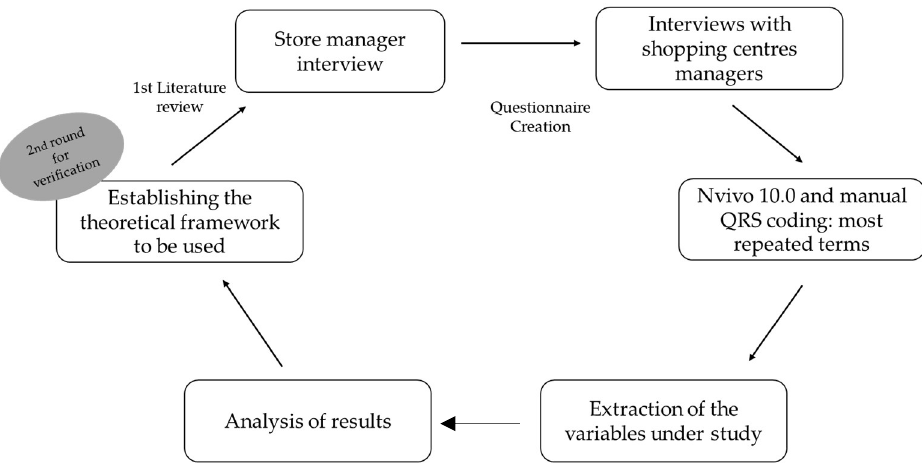
Figure 1. Research Strategy. Source: Adaptation [28].